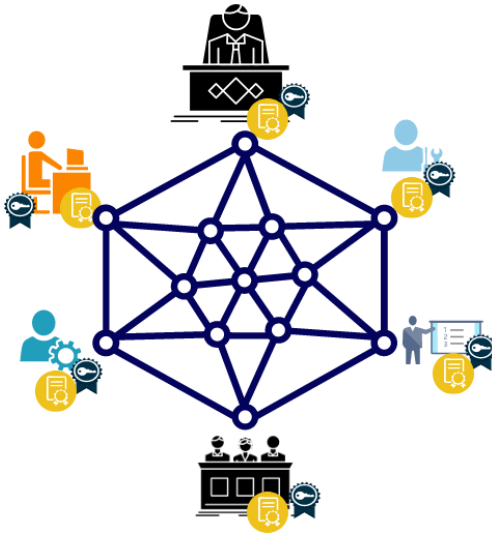
Figure 2. Private Blockchain.